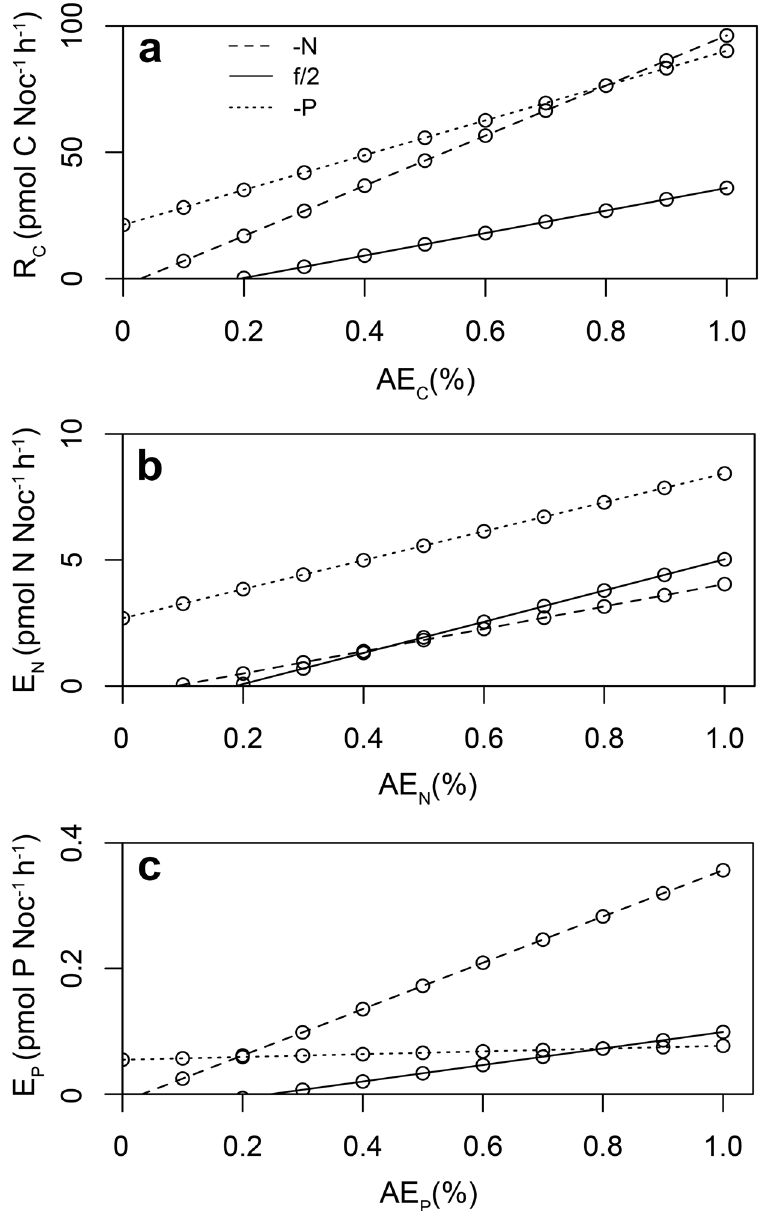
Figure 3. Predictions of the excretion rates of ( a ) C, ( b ) N and ( c ) P of Noctiluca scintillans (pmol Noc − 1 h − 1 ) grown on N-limited (-N), nutrient-balanced (f/2) and P-limited (-P) prey as a function of their assimilation efficiencies for these elements using elemental budget